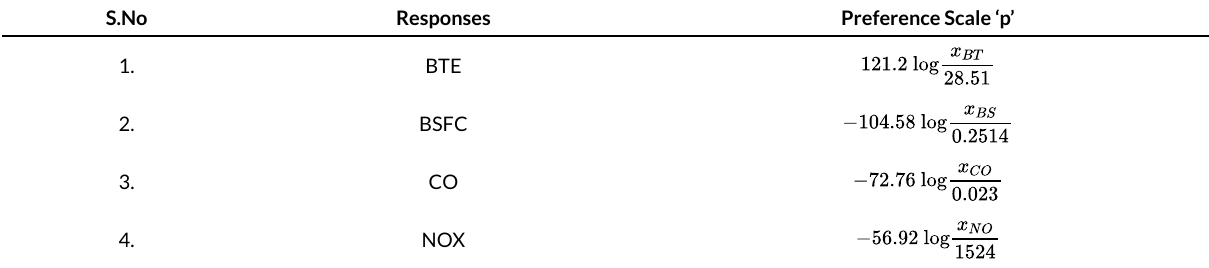
TABLE 4. PREFERENCE SCALES